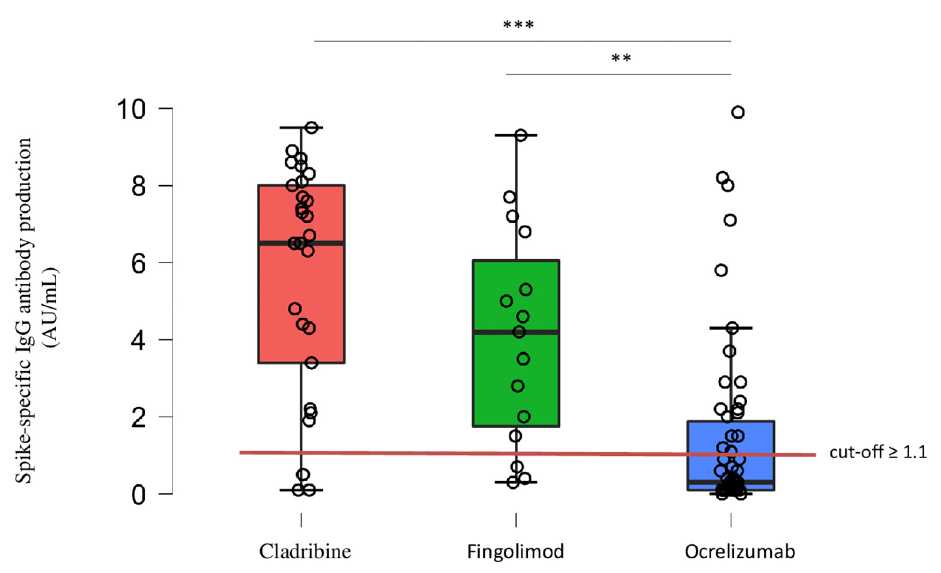
Figure 1. Anti-spike IgG titers. Anti-spike IgG titers (indicated as circles), obtained by EIA test (cut-off ≥ 1.1 AU/mL), was significantly lower in seroconverted o-pwMS ( n = 20/54, 37%) compared to c-pwMS ( n = 25/29, 86%; *** p < 0.001) and f-pwMS ( n = 12/15, 80%; ** p = 0.003, ANCOVA followed by post-hoc pairwise comparison using the Tukey test). ** p < 0.01, *** p < 0.001.